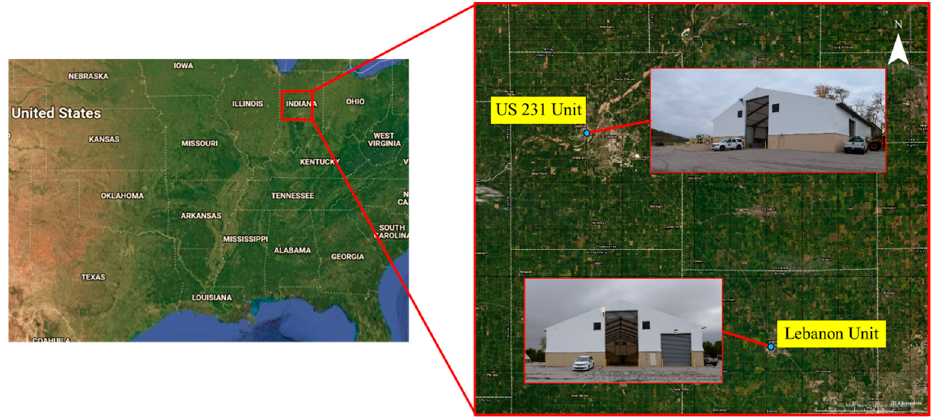
Figure 5. Locations of surveyed salt storage facilities: Lebanon unit and US-231 unit of West Lafayette, both in Indiana, USA. Table 2. Summary of the captured salt storage facilities.